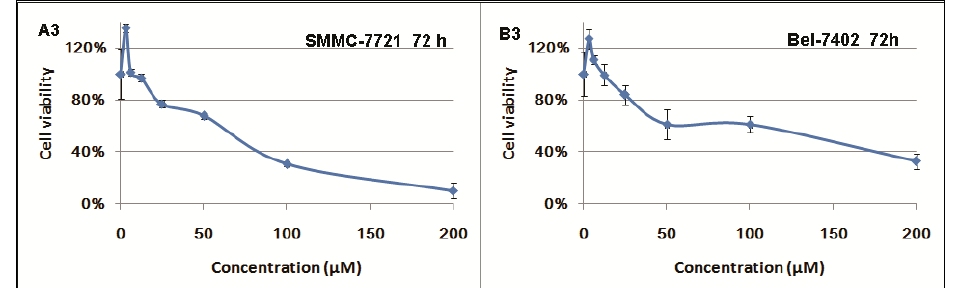
Figure 1. Inhibitory effects of berberine (BBR) on hepatocellular carcinoma (HCC) cells for 24, 48 and 72 h by MTT assay. SMMC-7721 cells were treated with different concentration of BBR (from 0 to 200 μ M) for 24 ( A1 ), 48 ( A2 ) and 72 h ( A3 ). Cell viability was detected and calculated; Bel-7402 cells were treated with different concentration of BBR (from 0 to 200 μ M) for 24 ( B1 ), 48 ( B2 ) and 72 h ( B3 ). Cell viability was detected and calculated.